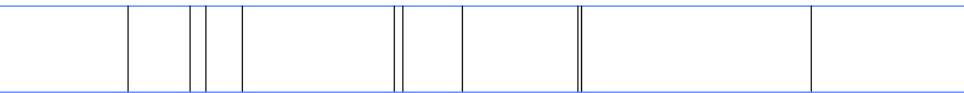
Fig. 3. The frequency of use of the concept of ‘events’ (source No. 17) (Developed by the author using AntConc